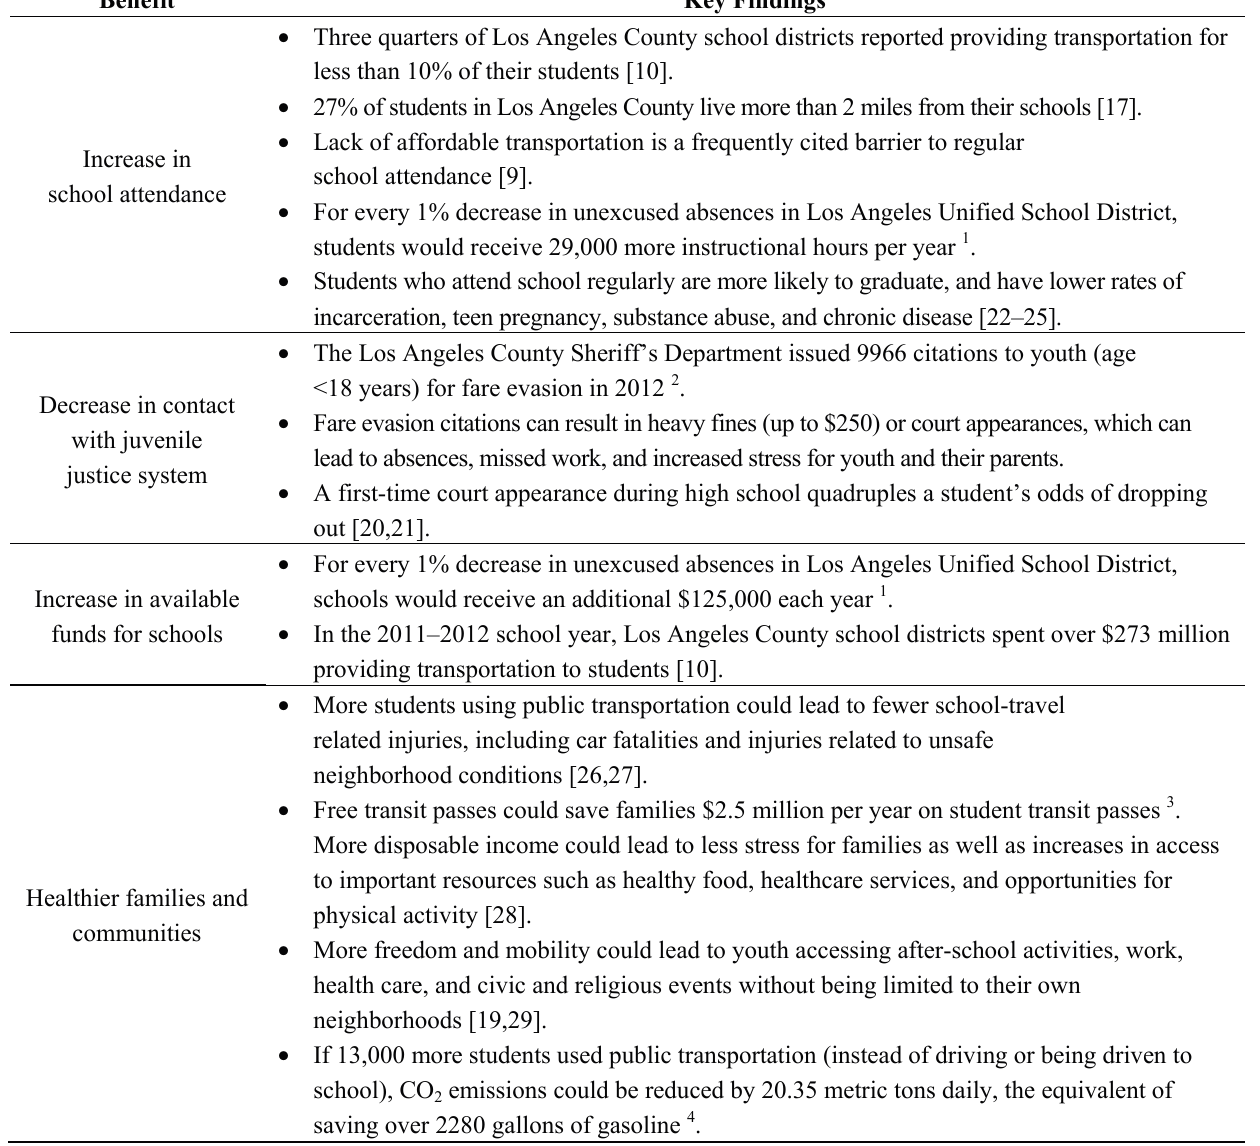
Table 2. Potential benefits of providing free transit passes to student in Los Angeles County,